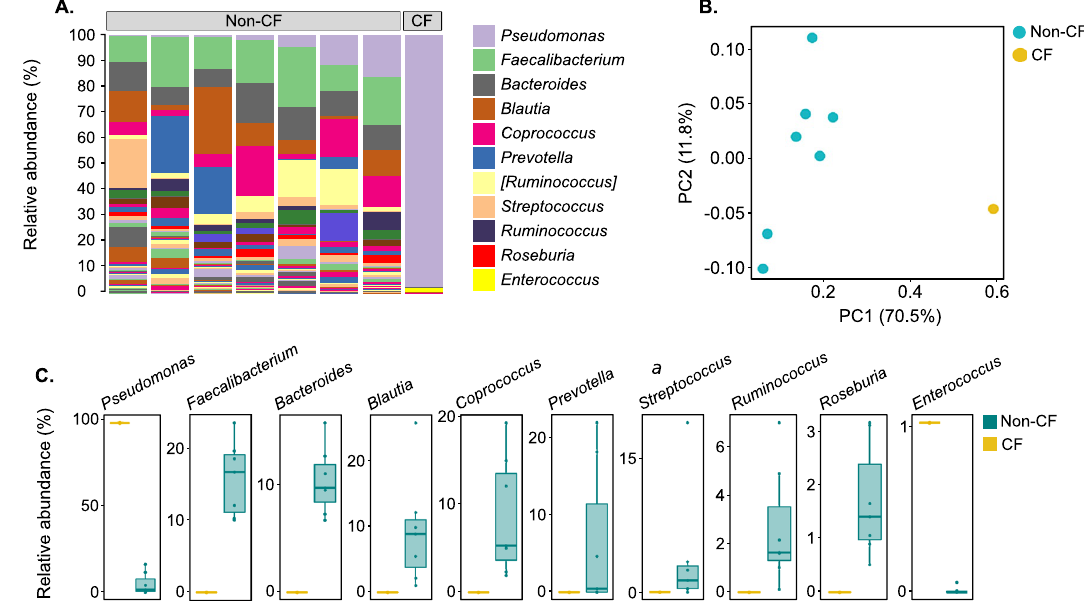
Figure 3. ( A ) Stacked bar plot showing genus-level microbial composition of the ileal mucosa-attached microbiome in a CF and non-CF human sample(s), ( B ) Principal co-ordinates analysis (PCoA) plots from weighted Unifrac distances of the ileal mucosa-attached microbiome from CF and non-CF human samples with colours representing disease status and ( C ) Box and whisker plots showing the relative abundance of the differentially abundant genera in each patient group. Boxplots display the median as the midline whilst the perimeters of the box display the 1st and 3rd quantiles of the data. The percentage of variation captured by each PCoA axis is